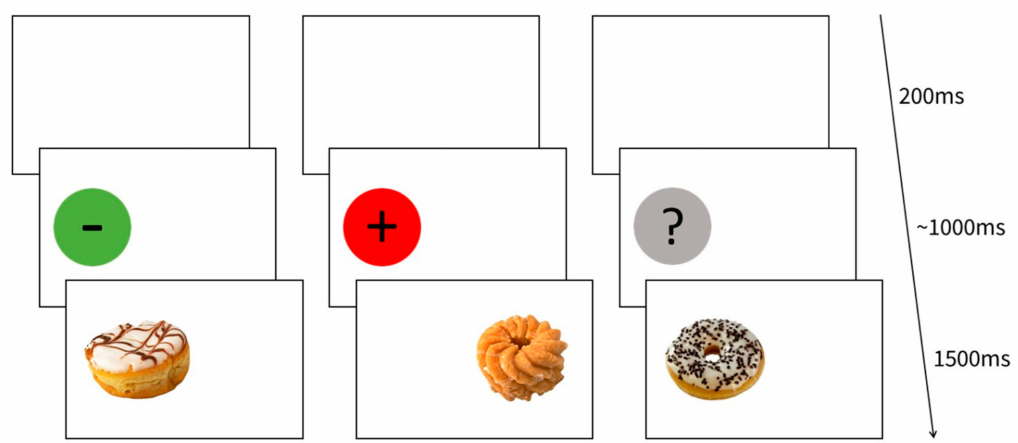
Figure 1. Example trials for (from left to right) low sugar label, high sugar label, and unknown sugar label. Each food image was presented twice: Once in the same location as the label (example: low sugar & unknown sugar) and once in the peripheral location (example: high sugar label). In 50% of trials, the label was presented on the left side of the screen. In the other 50%, the label was presented on the right side of the screen (not displayed